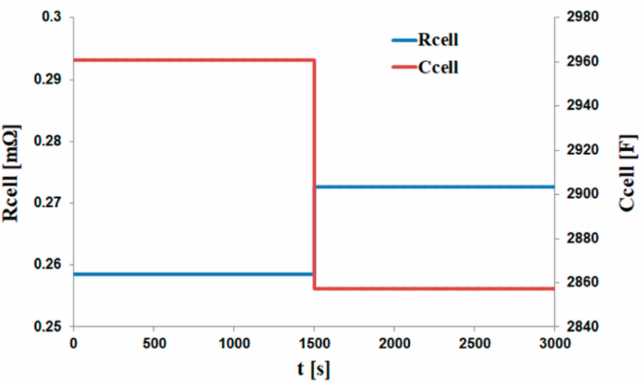
Figure 8. Sc parameter variations when temperature varies from 10 to 45 ◦